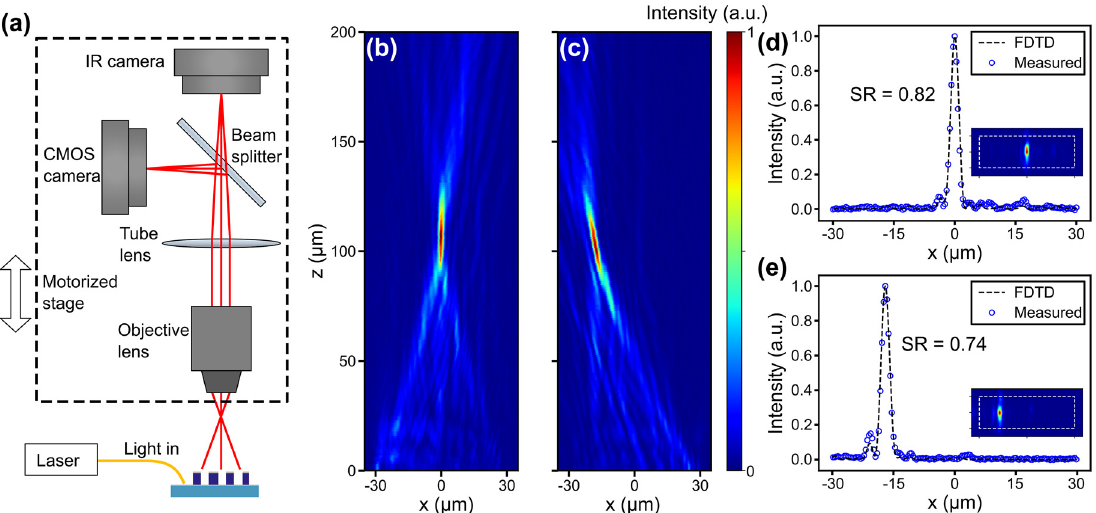
Figure 4: Measurement of the integrated metasurface for generating a switchable focusing emission profile. (a) Schematic of the measurement setup. (b, c) Measured intensity distributions on the xz plane when the metasurface is excited by the + x (panel b) and − x (panel c) propagating guided modes. The emission angle is tilted by − 10 ◦ in panel c, showing a switchable operation. (d, e) Cross-sections of the measured and FDTD-simulated intensity distributions at the focal plane when the metasurface is excited by the + x (panel d) and − x (panel e) propagating guided modes. The peak intensity is normalized to 1. The measured Strehl ratios are 0.82 and 0.74 in panels d and e, respectively. Insets: 2D intensity distributions on the focal plane, where the white dashed line indicates an area of 60 μ m × 20 μ m. SR: Strehl